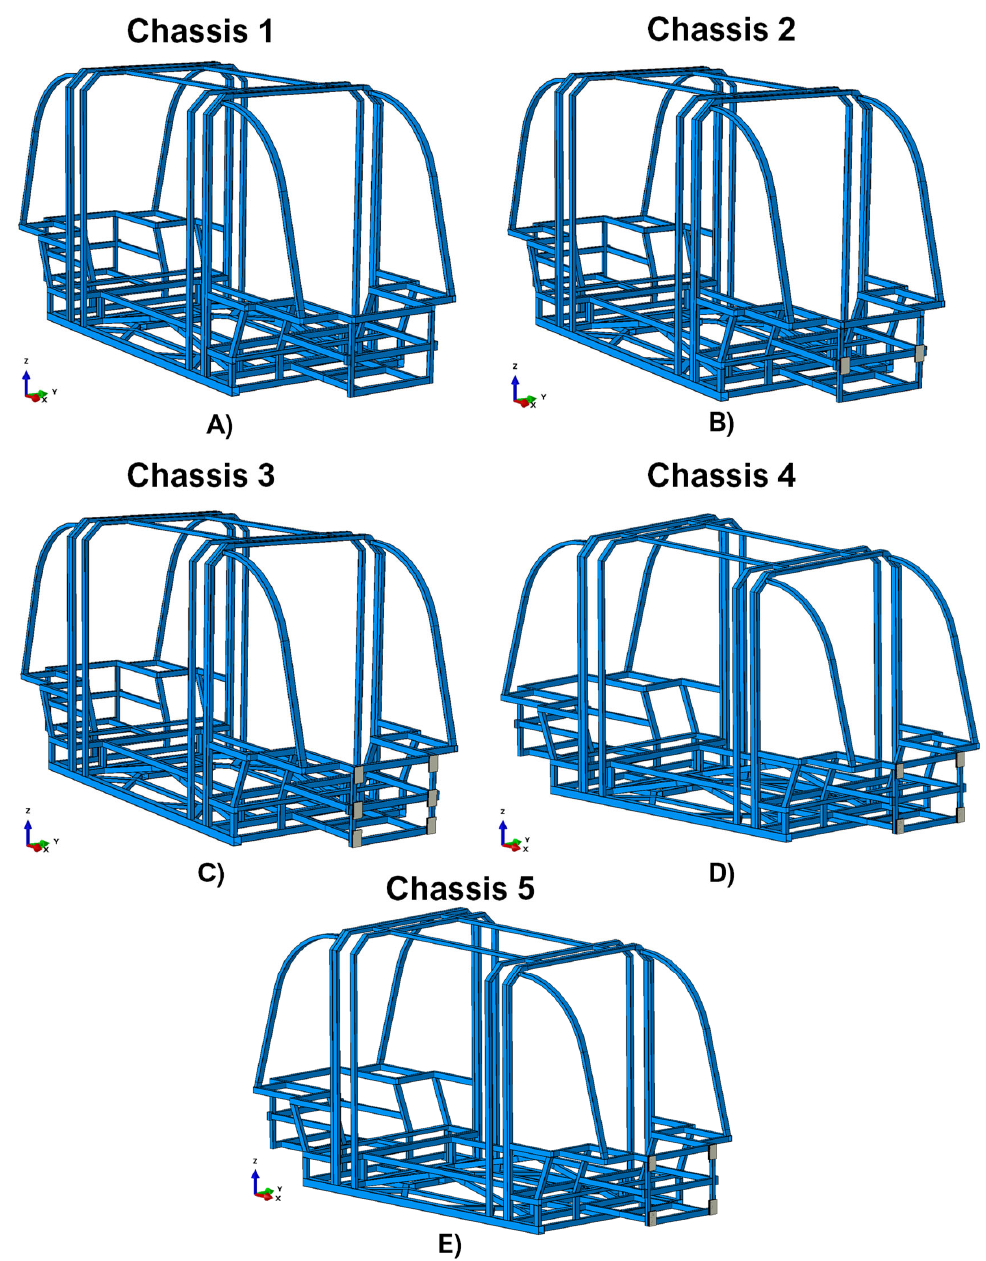
Figure 1. Explored chassis configurations. ( A ) Configuration not equipped with damping systems (Chassis 1); ( B ) Configuration with a damping system composed by two shock absorbers (Chassis 2); ( C ) Configuration with a damping system composed by six shock absorbers (Chassis 3); ( D ) Configuration with a damping system consisting of four shock absorbers with a higher polymer core than the other ones (Chassis 4); ( E ) Configuration with a damping system consisting of four shock absorbers with a thin polymer core (as the one in Chassis